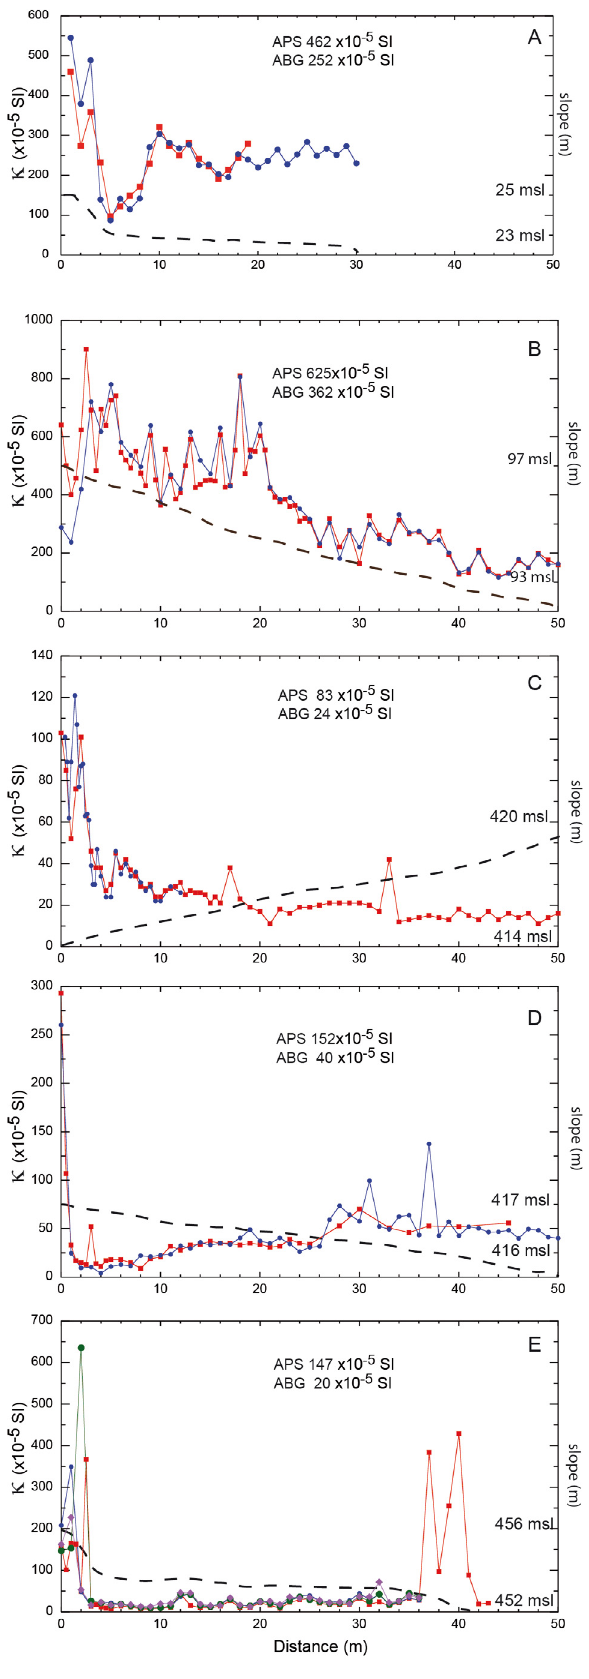
Figure 2. Magnetic susceptibility field profiles for sites SS17 (A), SS39 (B), SS50 (C), SS87 (D), and SS94 (E). Dashed dark line represents the trend of slope profile. APS: is the averaged peak magnetic suscepti- bility value; ABG: is the averaged magnetic susceptibility back- ground